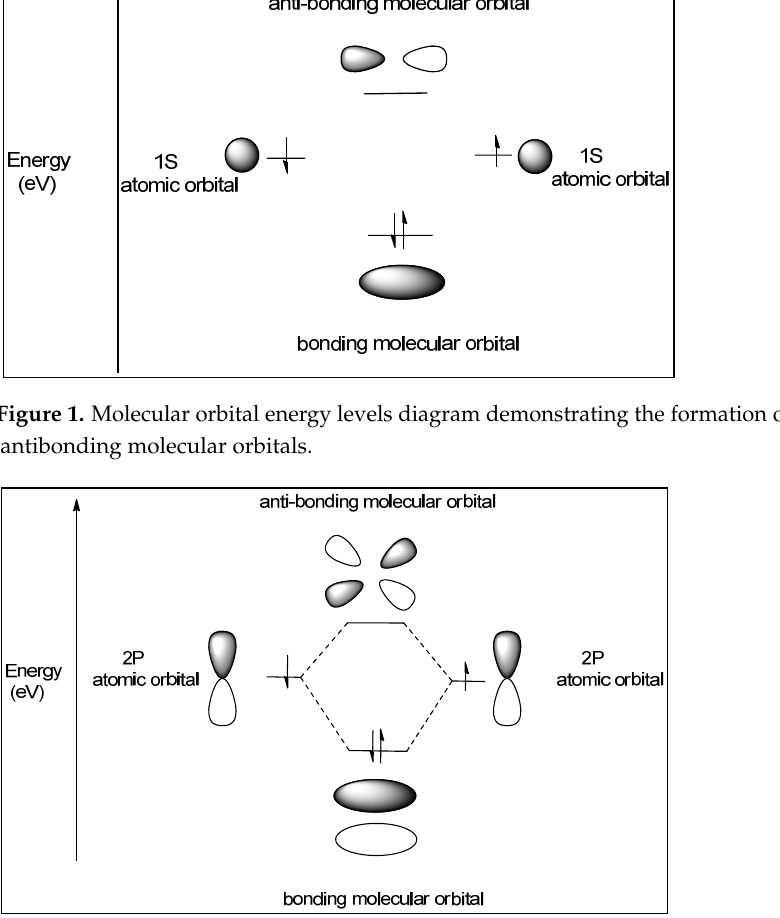
Figure 1. Molecular orbital energy levels diagram demonstrating the formation of σ -bonding and σ ̽ -antibonding molecular orbitals.